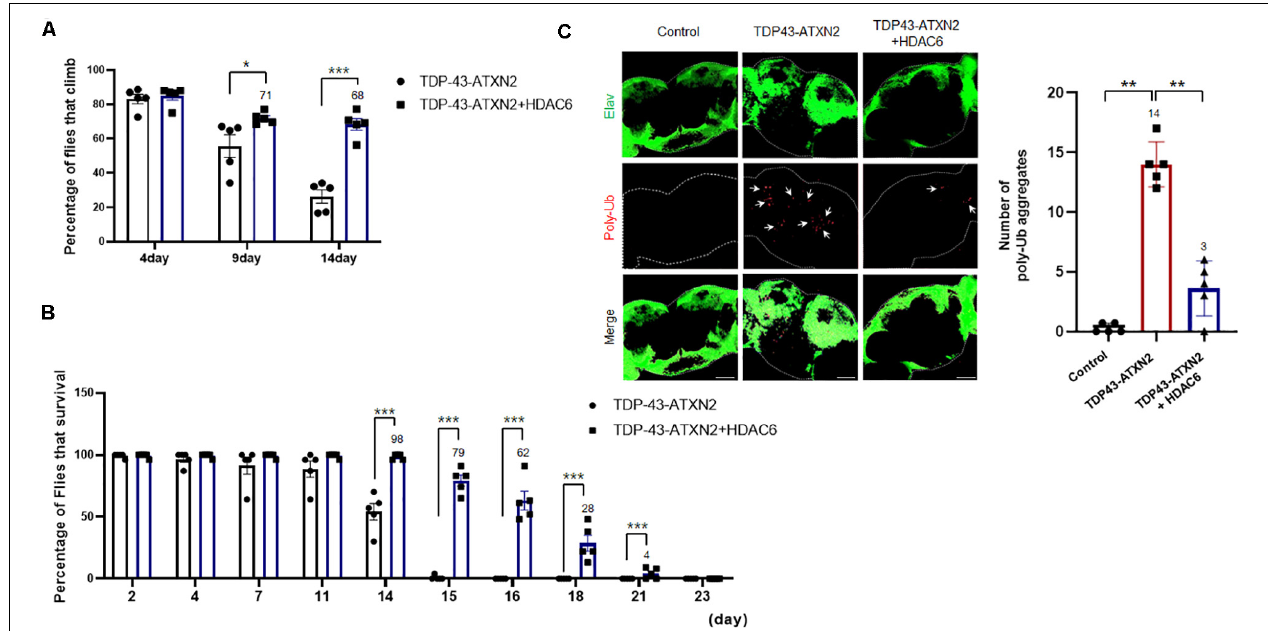
FIGURE 5 | HDAC6 overexpression mitigates neuronal toxicity and ubiquitin aggregates in a fly model of TDP-43 proteinopathies. (A,B) Climbing ability and shortened lifespan of TDP-43/ATXN2 or TDP-43/ATXN2+HDAC6 flies at the indicated time-points. The TDP-43/ATXN2-induced motility deficit was significantly rescued by overexpression of HDAC6. Quantification of the percentage of flies that climbed and survived. Data are presented as the mean ± SEM of four independent experiments. * p < 0.05, and *** p < 0.001 (Student’s t -test). (C) The brains of TDP-43/ATXN2 or TDP-43/ATXN2+HDAC6 flies were immunostained for polyubiquitin (red) and Elav (green). Overexpression of HDAC6 significantly reduced the accumulation of ubiquitinated inclusions in the brains of TDP-43/ATXN2+HDAC6 flies. Elav is a marker of most differentiated neuronal cells in the central and peripheral nervous systems of Drosophila . The quantification of the number of polyubiquitin-positive inclusions per brain is shown ( right ). Arrowheads indicate polyubiquitin-positive inclusions. Data are presented as the mean ± SEM of four independent experiments. **p < 0.001 (one-way ANOVA with Bonferroni multiple comparison test). Scale bars, 50 µ m. Genotypes: Control is elavGS/+ , TDP-43/ATXN2 is UAS-ATXN2-32Q/+; elavGS,UAS-TDP-43/+ , TDP-43/ATXN2+HDAC6 is UAS-ATXN2-32Q/UAS-HDAC6; elavGS,UAS-TDP-43/+